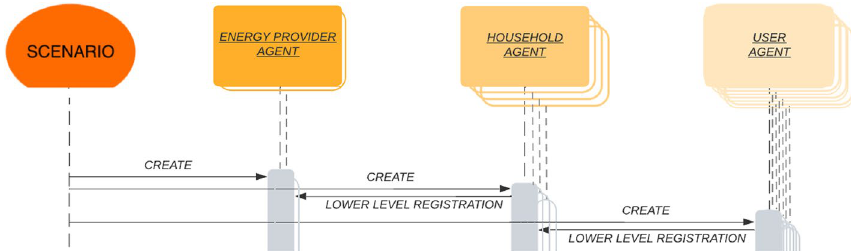
Fig. 1 Diagram of the scenario initialisation of the hierarchical agent-oriented